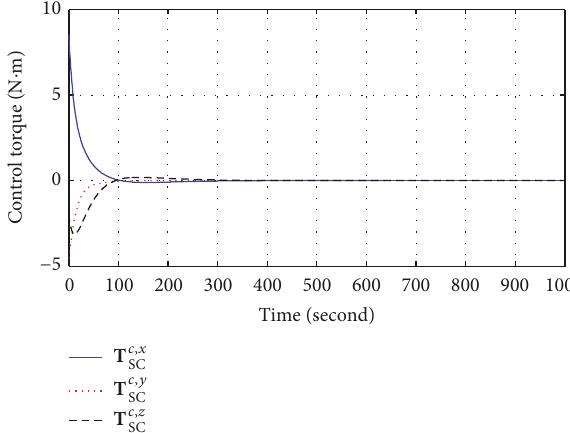
Figure 7: Components of control torque on the three axes of the